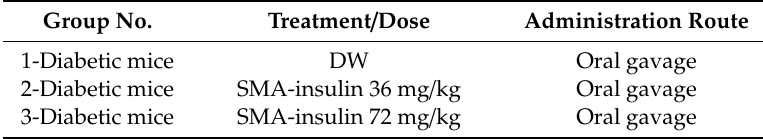
Table 2. Insulin and SMA-insulin treatment groups for diabetic mice. Group